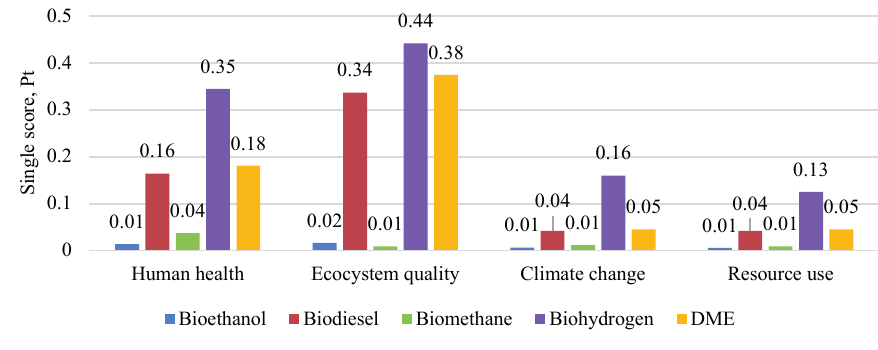
Fig. 2. LCA results by categories of